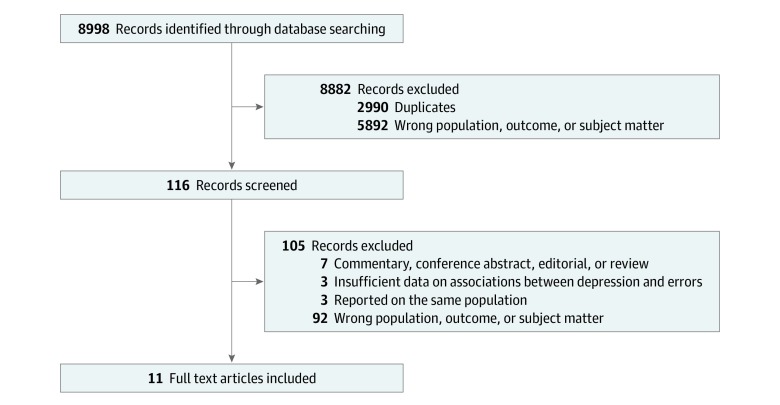
PRISMA Flow Diagram